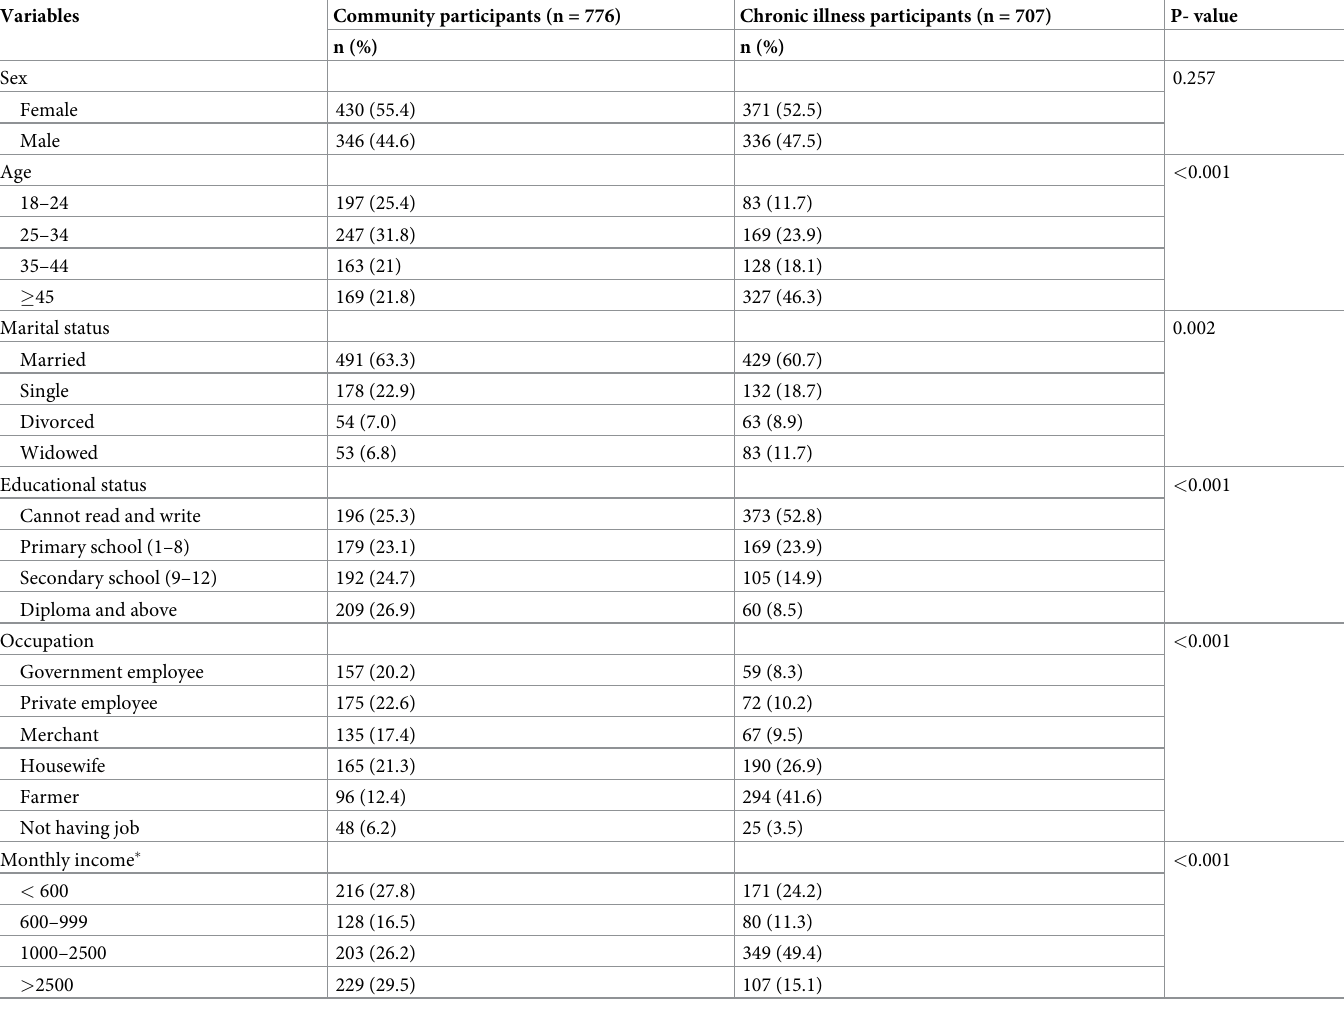
Table 1. Socio-demographic characteristics of chronic medical illnesses and general community participants in Mecha demographic research center,